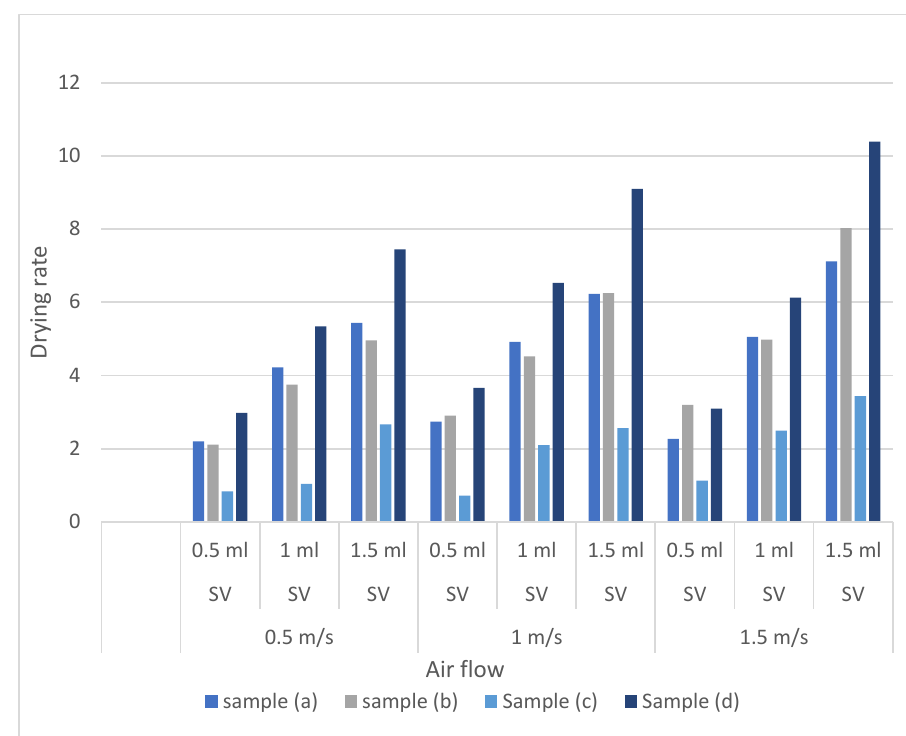
Figure 7. Sweat drying rate under different ambient condition.